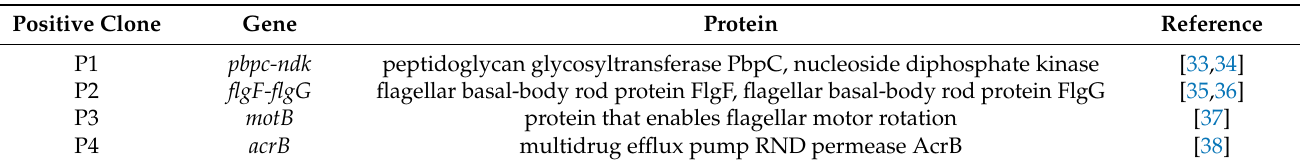
Figure 2. Effect of varying pinene concentrations on the growth of E. coli . Table 2. Identification of the genes in the clones by using BLAST searches.